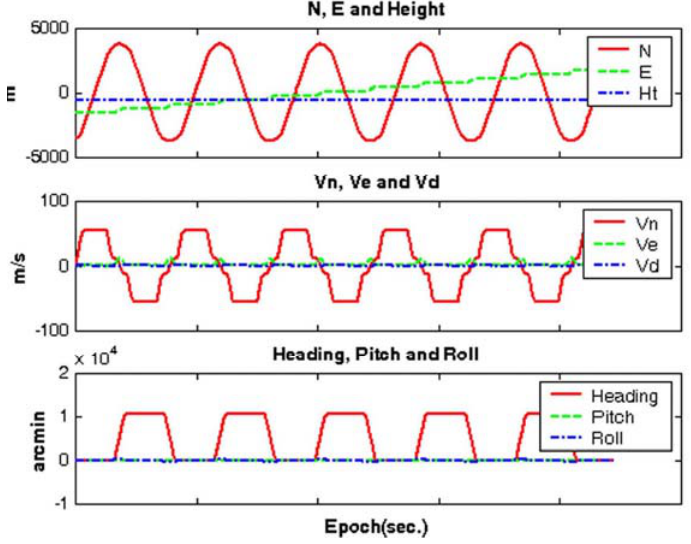
Figure 9. Example of the estimated navigation parameters (CASE